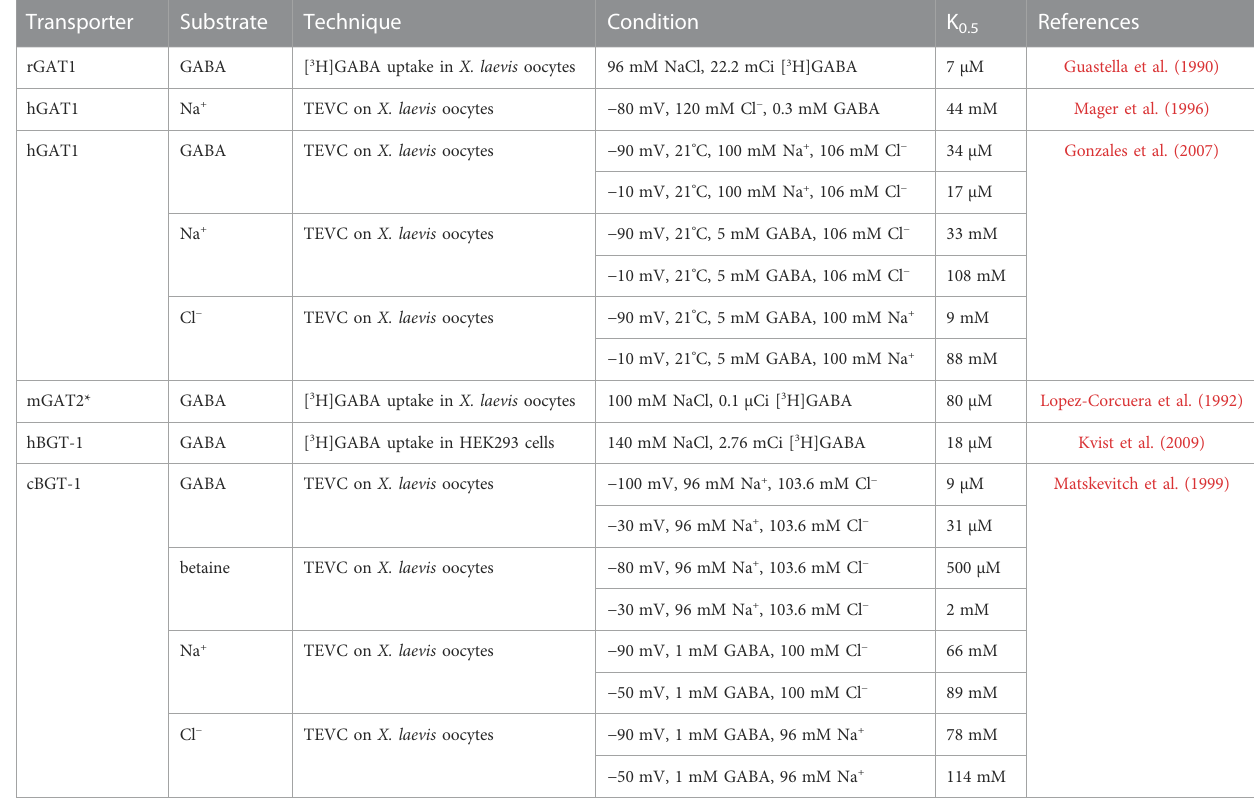
TABLE 2 Apparent af fi nities of the transporters GAT1 and BGT-1 for the respective substrates with different techniques, samples, and conditions.